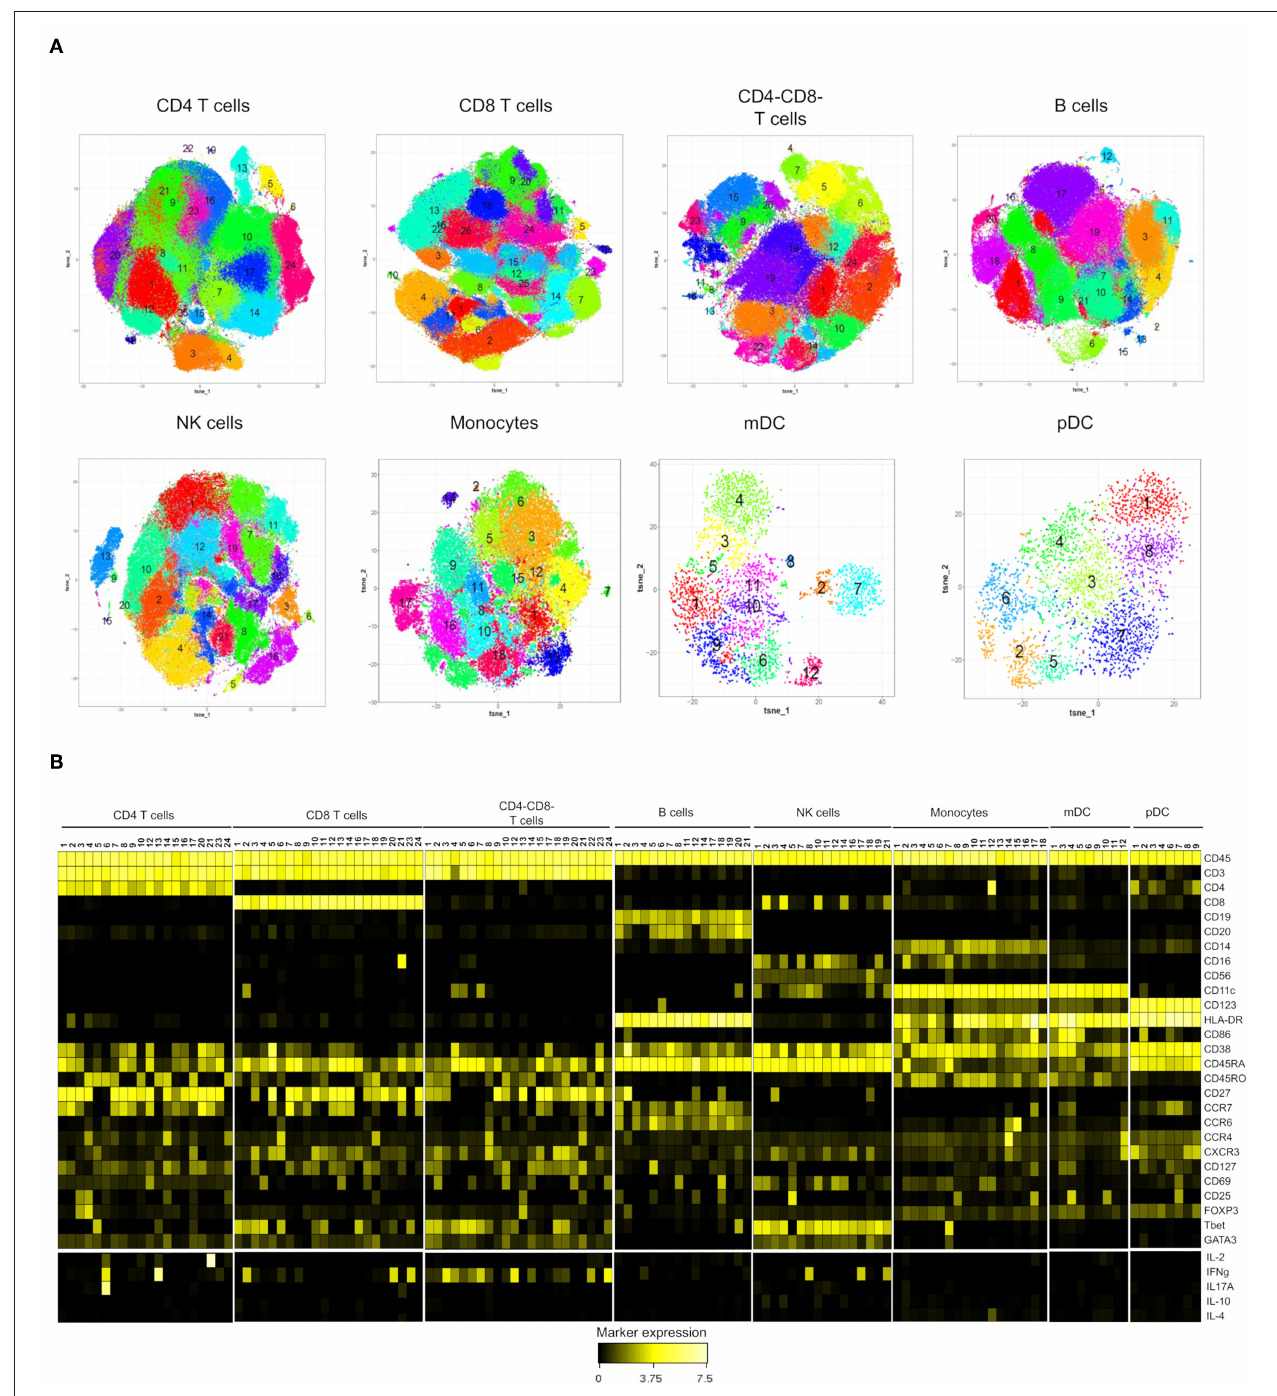
FIGURE 2 | Subset identification within the major immune populations in peripheral mononuclear cells from high-risk ( n = 9) and control individuals ( n = 9). (A) Phenotypically distinct subsets were identified with t-SNE combined with Phenograph analysis of each lineage population (colored areas) (B) Heatmap showing median expression of the markers expressed by the cell subsets identified in (A) . Subsets of CD4 + (11,18,19,22,25), CD8 + (15, 20, and 22), CD4-CD8- (11,16), B (9,10,13,15,16) NK (6,9,13,15,20), mDC (2,7,8) and pDC (5) were excluded from the heatmap. Cytokine (IL-2, IFN γ , IL-17A, IL-10, and IL-4) expression is shown as subtraction of the expression on un-stimulated PBMC from samples stimulated with PMA + ionomycin. Values were transformed using arcsinh function in a cofactor of 5.